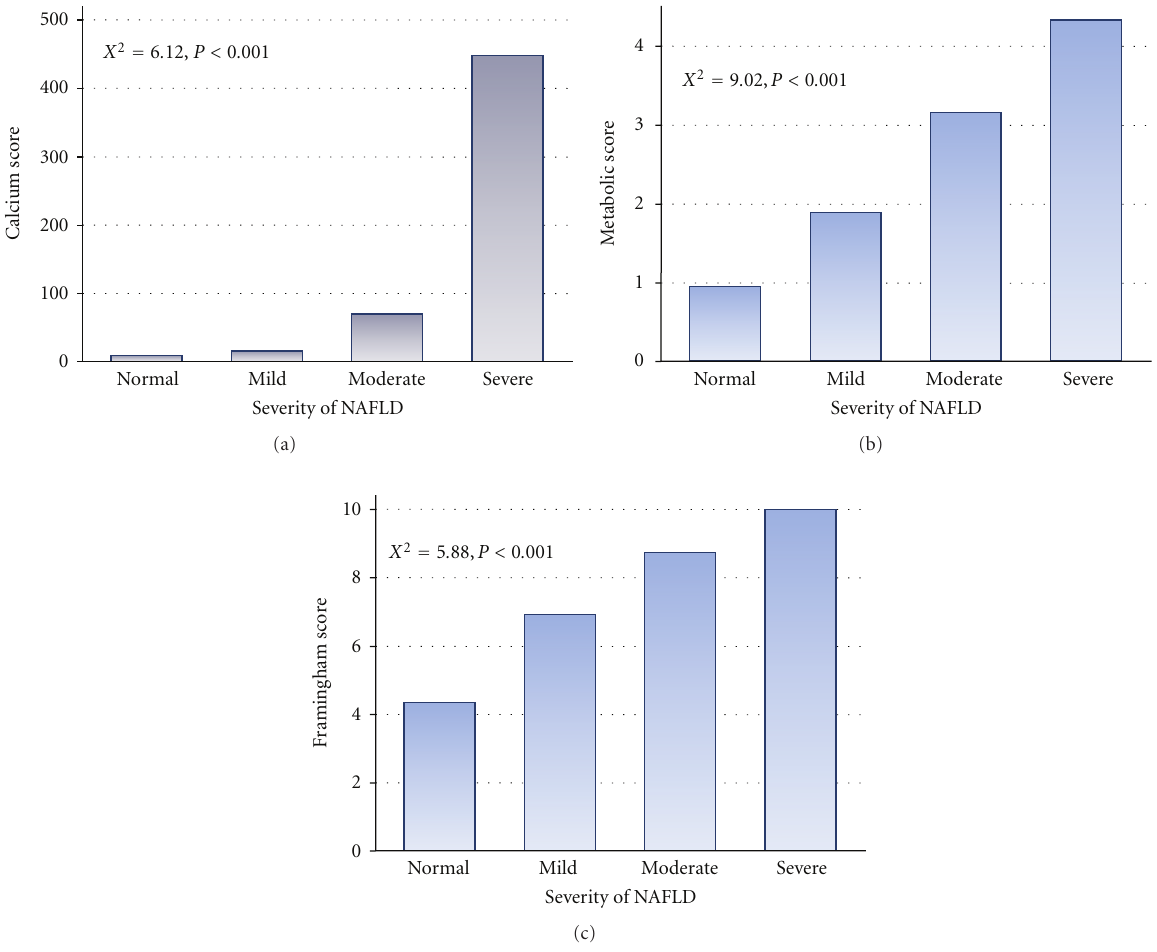
Figure 1: Estimated cardiovascular risk scores and coronary calcification categorized by the severity of nonalcoholic fatty liver disease. More severe fatty liver disease was associated with higher cardiovascular risk scores by either metabolic or Framingham risk scores and coronary calcium